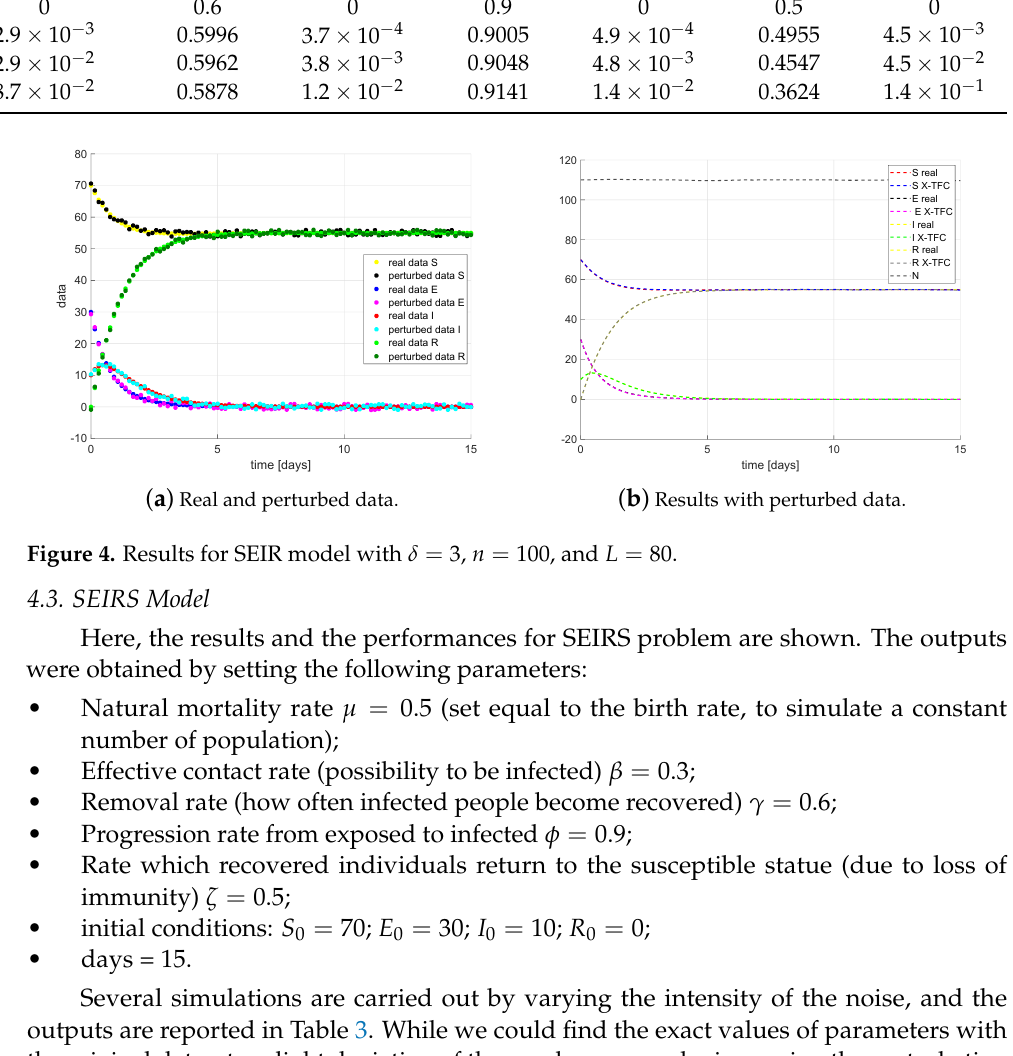
Table 2. Performances of the proposed physics-informed framework in the data-driven discovery of the SEIR model with different noise on the data, with n = 100 and L = 80, µ = ν = 0.5 (the training time is on the order of milliseconds). Noise